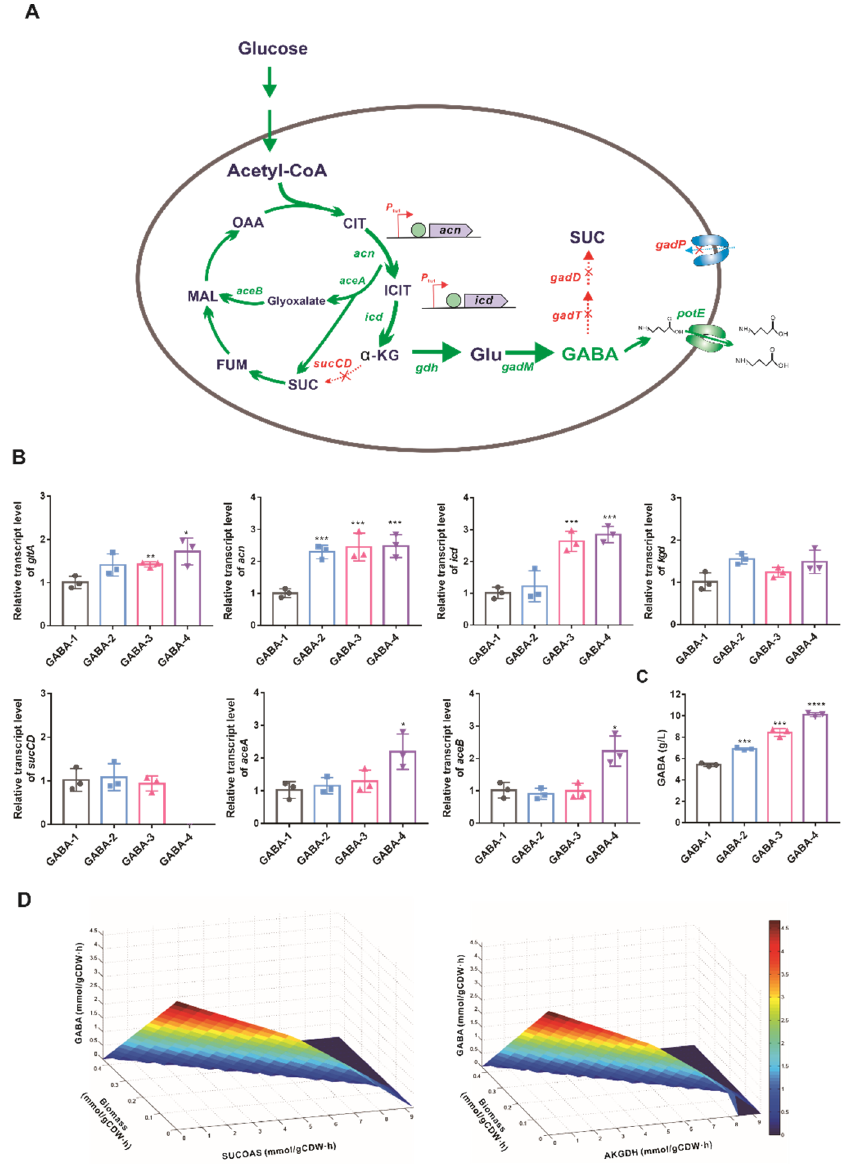
Figure 3. Reprogramming TCA cycle for GABA production. ( A ) The strategy for reprogramming the metabolic network for GABA biosynthesis. The red X represents the deletion of the corresponding gene. The green arrows indicate increased flux by gene overexpression. The enzymes encoded by the genes shown here are acn , aconitase; icd , isocitrate dehydrogenase; sucCD , succinyl-CoA synthetase; gdh , glutamate dehydrogenase; gadM , glutamate decarboxylase; gadT , 4-aminobutyrate-2-oxoglutarate transaminase; gadD , succinate-semialdehyde dehydrogenase; gadP , 4-aminobutyrate transporter; potE , bi-directional cadaverine transporter. Abbreviations: CIT, citrate; ICIT, isocitrate; α -KG, α -ketoglutarate; SUC, succinate; FUM, fumaric acid; MAL, malate; OAA, oxaloacetate; Glu, glutamate; GABA, gamma-aminobutyric acid. ( B ) Relative transcript levels of related genes of the GABA strains in the shake flask cultivations. ( C ) GABA productions in the shake flask cultivations of the engineered strains. ( D ) Simulation of the impact of AKGDH and SUCOAS fluxes on GABA productivity. Steady-state flux solutions were obtained using the GABA productivity as an objective function in combination with varying the AKGDH/SUCOAS flux and the growth rates. Data are presented by mean values with the standard deviation from three biological replicates. Significant differences were determined using Student’s t test (* p < 0.05, ** p < 0.01, *** p < 0.001, **** p <